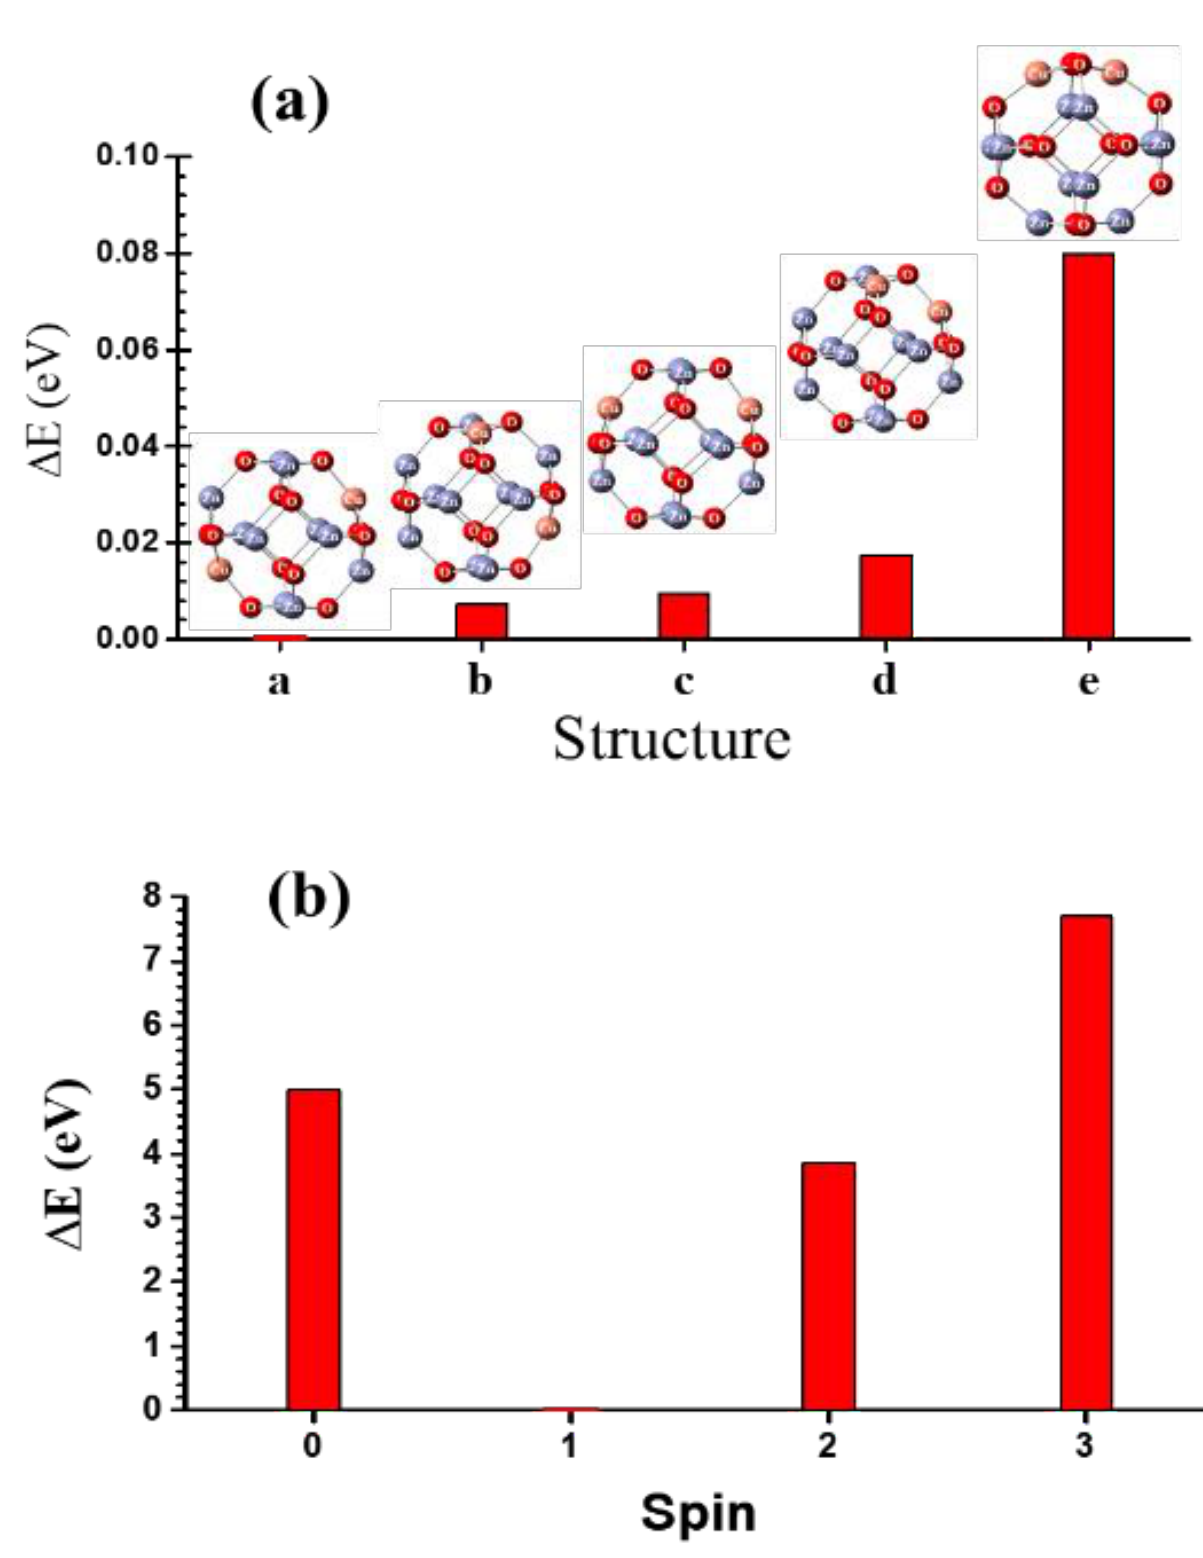
Figure 2. ( a ) The energy variations (ΔE) of the structures relative to the most stable structure. The fully optimized structures are inserted. ( b ) The energy variations (ΔE) versus the spin of the most stable structure.